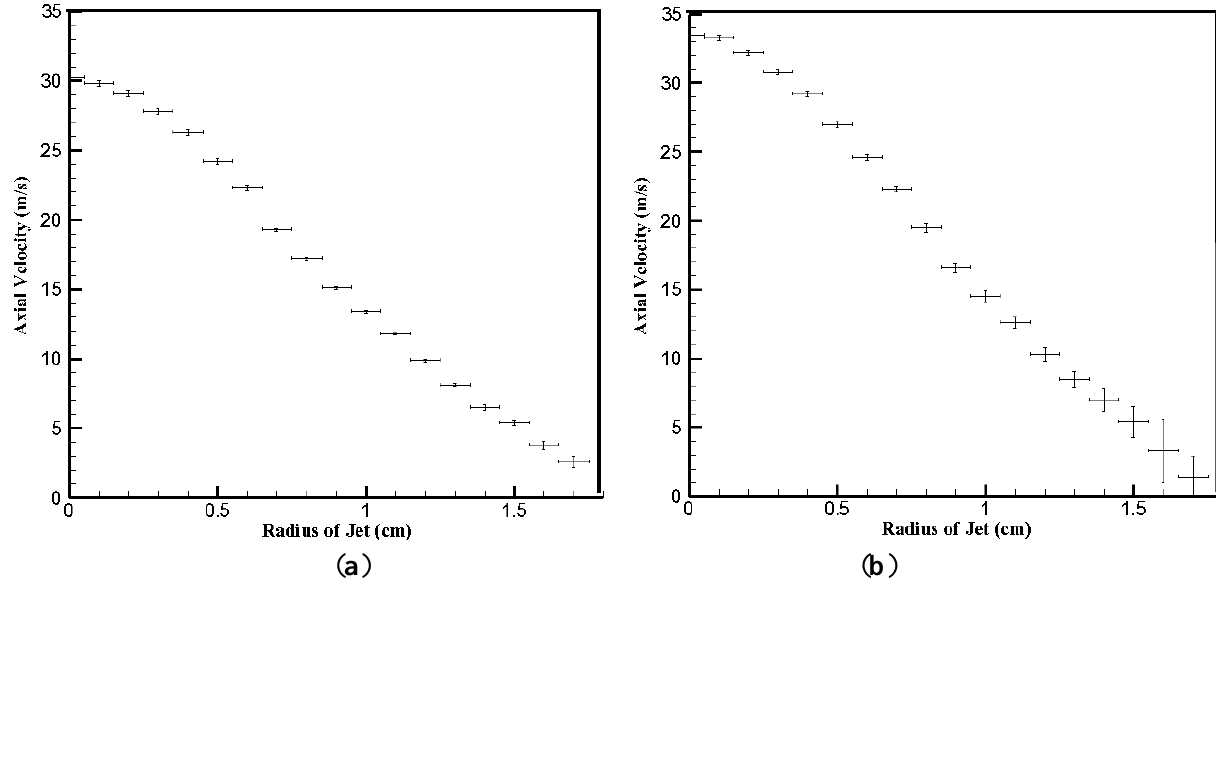
Figure 6. Axial velocity vs. radius for ( a ) Experiment 1 at z = 10 cm; ( b ) Experiment 2 at z = 10 cm; ( c ) Experiment 3 at z = 10